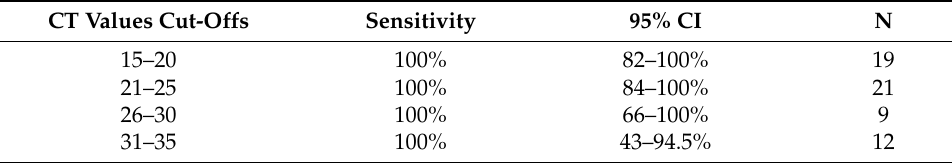
Table 2. Sensitivity of Visby device depending on RT-qPCR CT values.